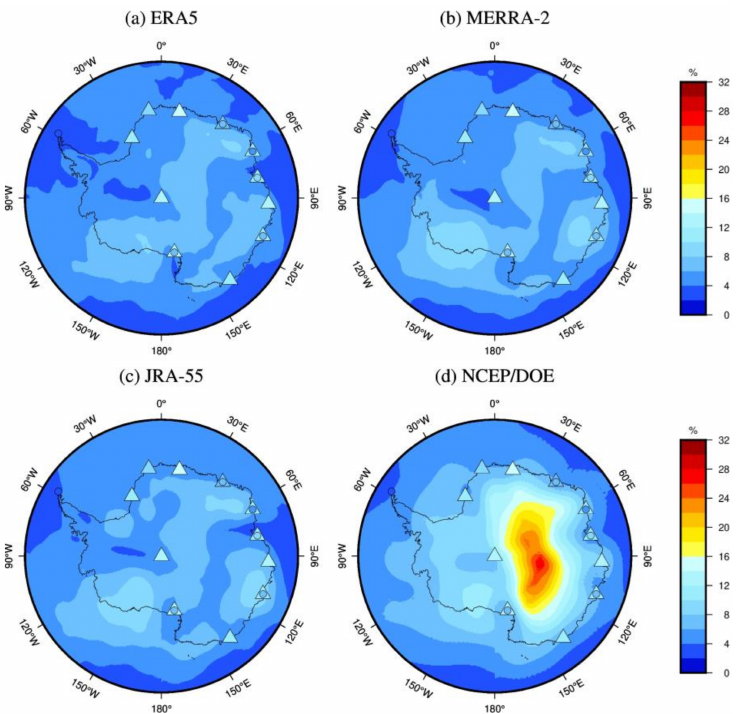
Figure 9. PWV relative variability over Antarctica for 2001 to 2018 derived from ( a ) ERA5, ( b ) MERRA-2, ( c ) JRA-55, ( d ) NCEP/DOE reanalysis (color shading), GNSS (color circles) and radiosonde (color